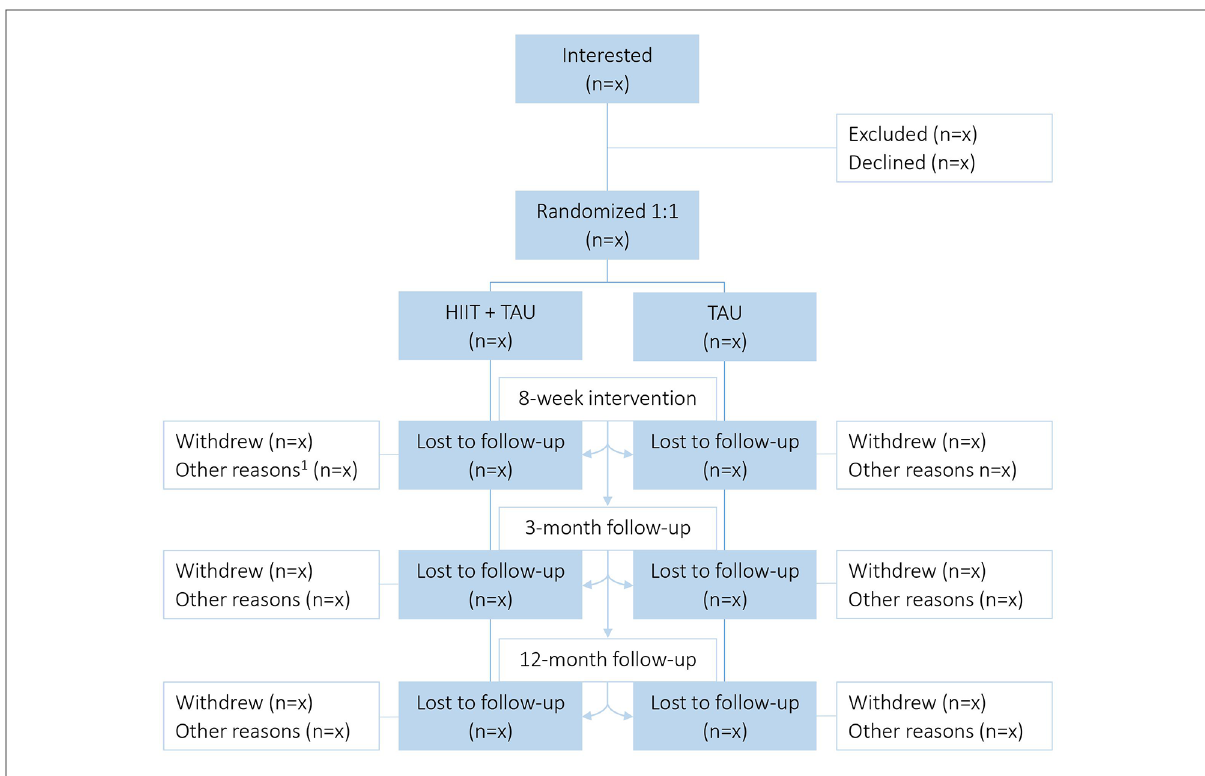
FIGURE 2 Study fl ow chart. HIIT, High-intensity interval training; TAU, Treatment as usual; 1=for intervention: unable to complete/discontinuation (e.g. sick, relapse), missing data; for follow-up periods: unable to contact after ended